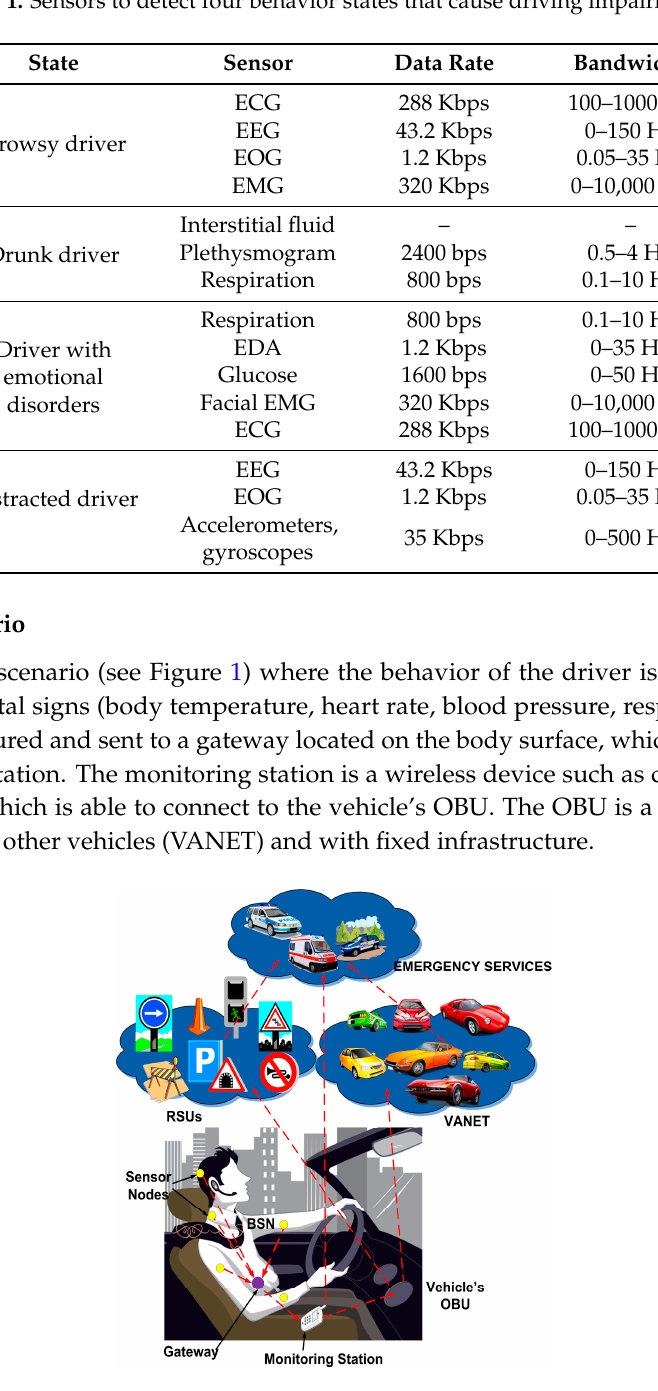
Figure 1. Proposed scenario.